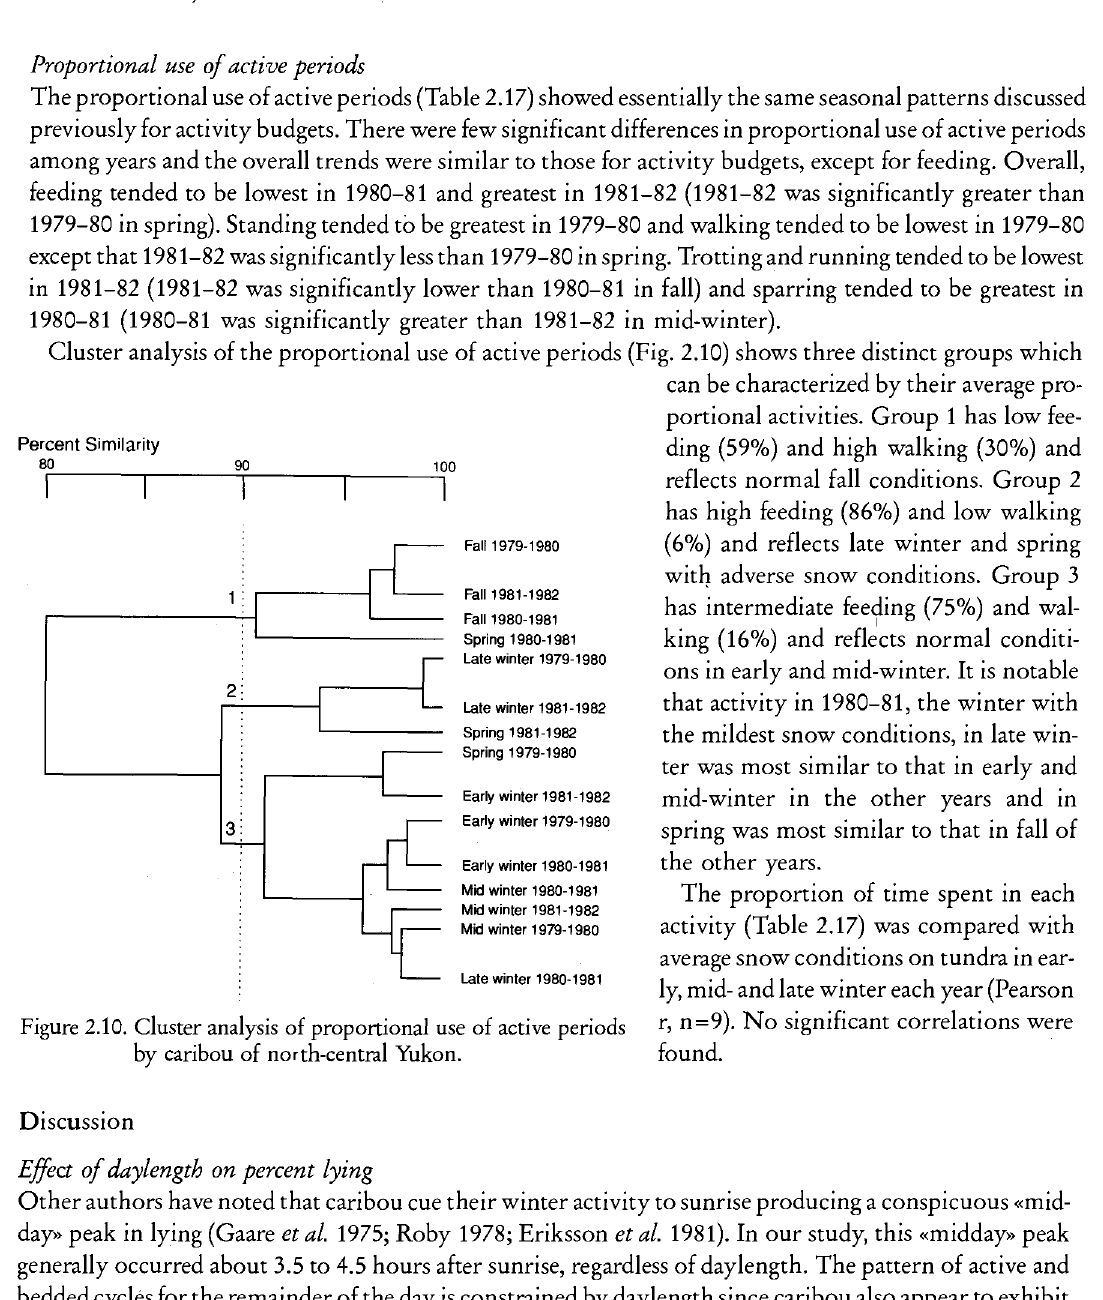
Figure 2.10. Cluster analysis of proportional use of active periods by caribou of north-central